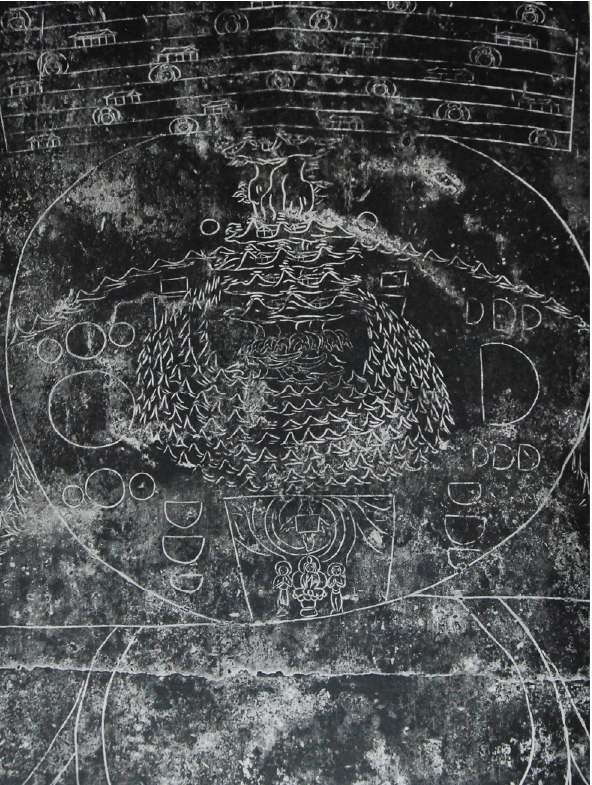
Figure 7. Heavenly realms and Mt. Sumeru. Line carving on the bronze pedestal (detail). Seated Vairocana Buddha. Reproduced from Nara Rokudaiji Taikan Kank ō kai (2001), p. 169.